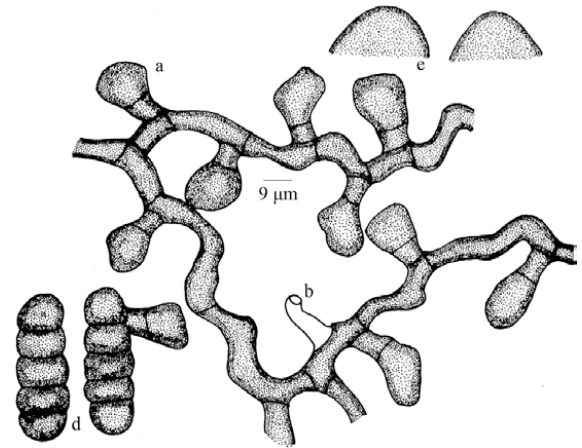
Figure 3. Asteridiella colocasiae sp. nov. a - Appressorium; b - Phialide; d - Ascospores; e - Peridial cells